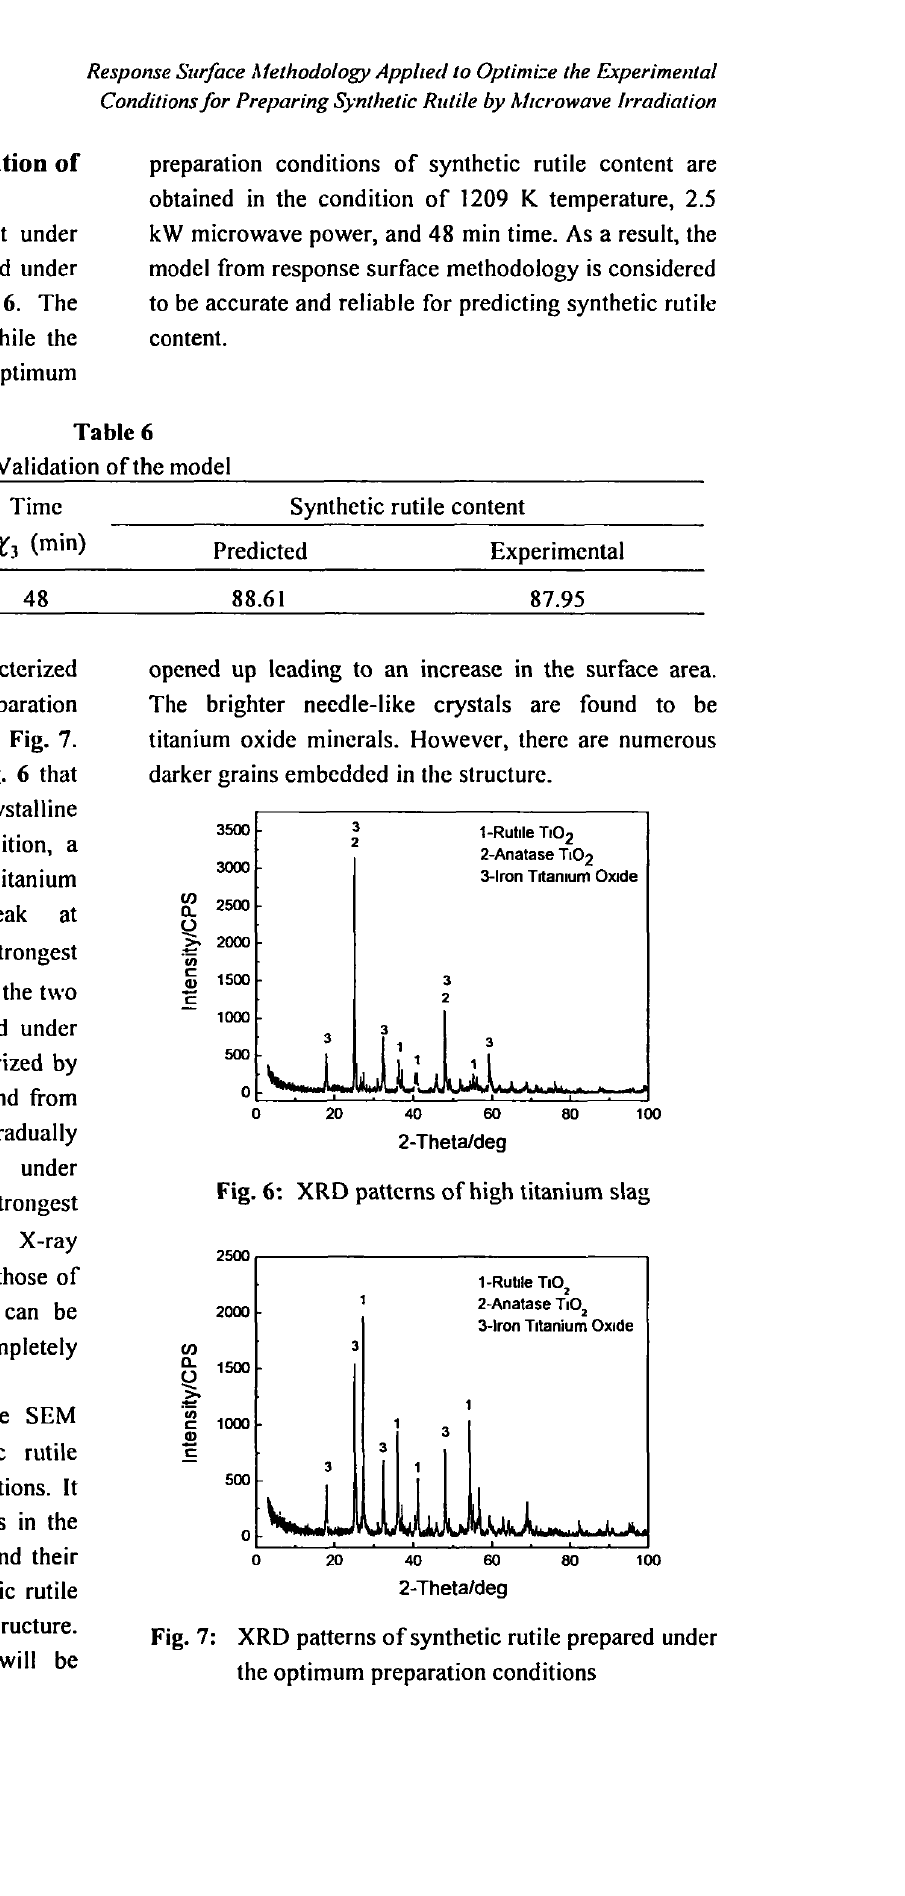
Fig. 7: XRD patterns of synthetic rutile prepared under the optimum preparation